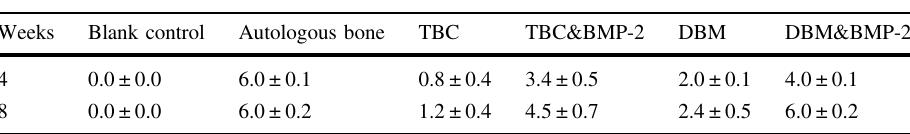
Table 4 Histological scoring of radial repair